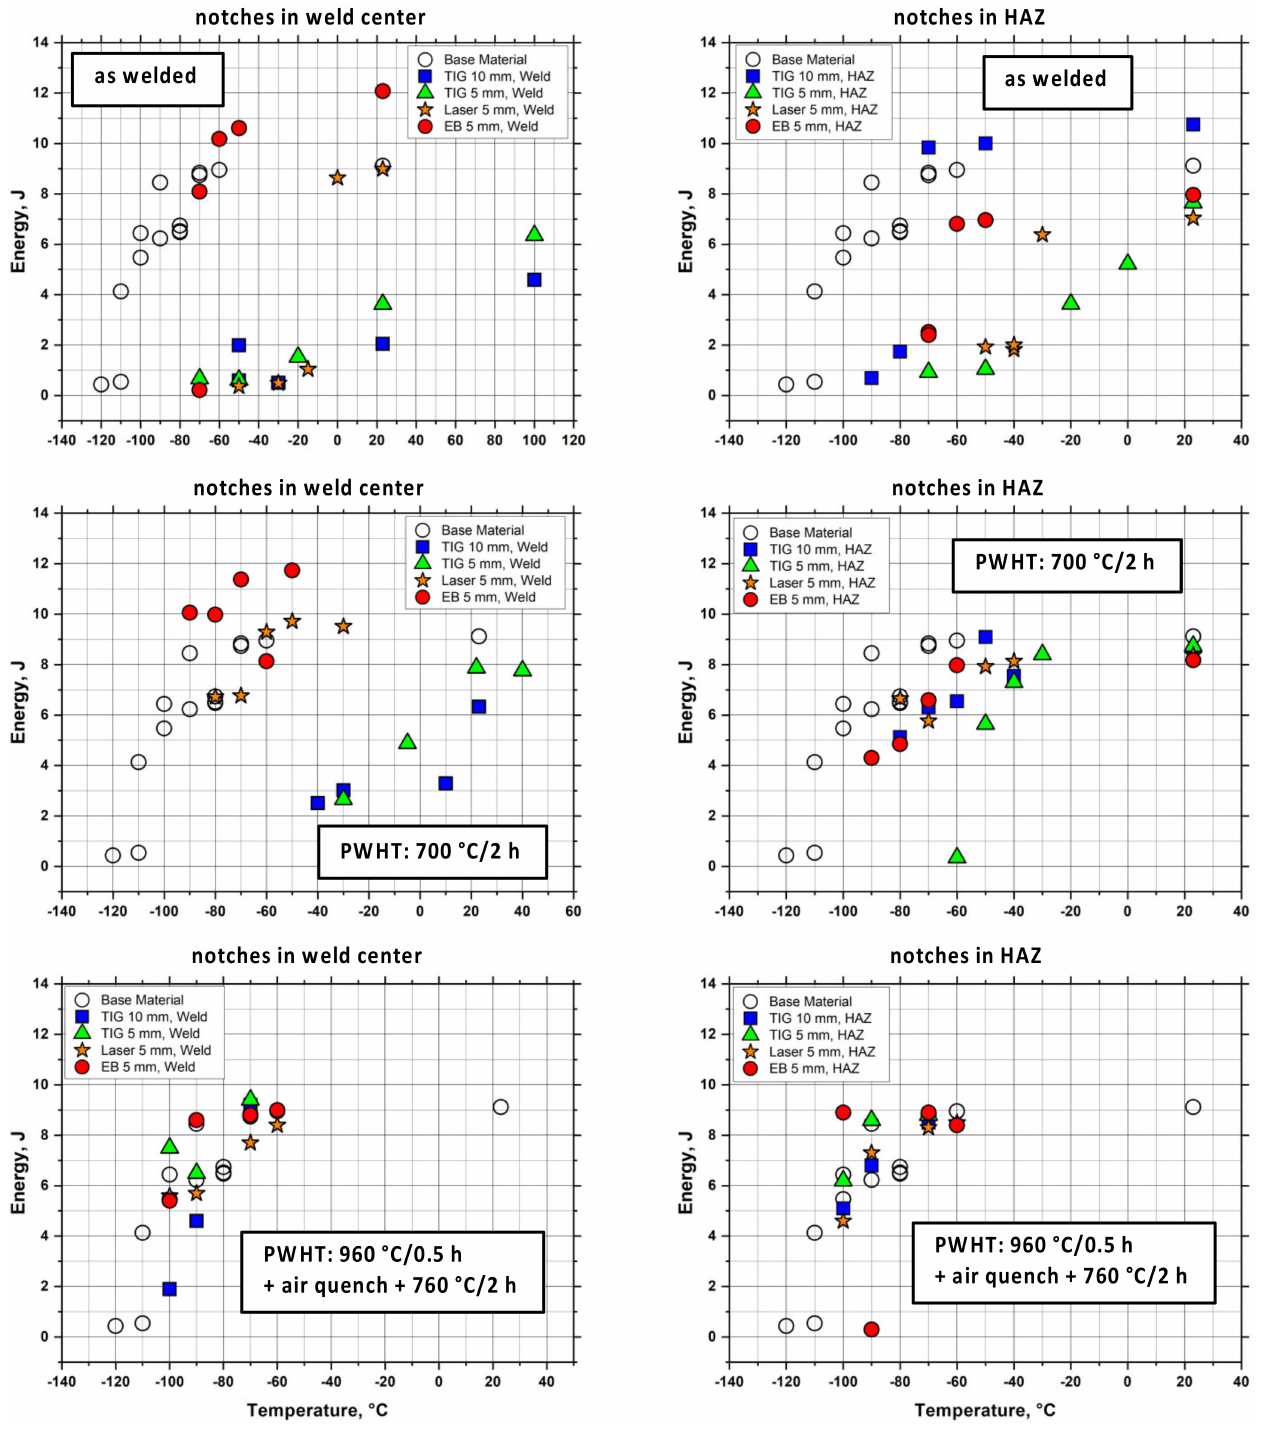
Figure 14. Charpy test results of 5 mm and 10 mm TIG, laser and EB welds. The notches of the Charpy specimens were fabricated in the top of the weld centers and HAZs. The graphs show results from the condition as welded, after a PWHT of just tempering at 700 ◦ C for 2 h, and after a PWHT of 960 ◦ C/30 min + air quenching + 760 ◦ C for 2 h. For comparison, each graph shows the properties of the base material (EUROFER97/2) after standard heat